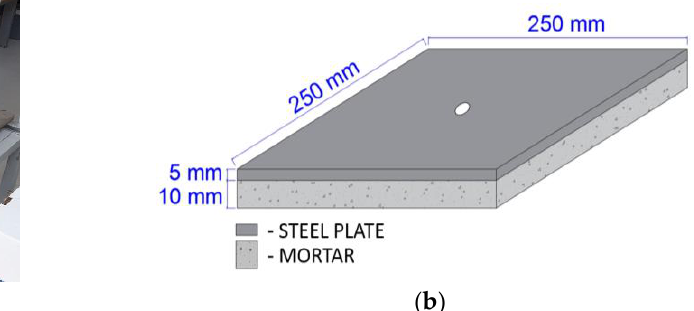
Figure 2. Manufacture of specimens: ( a ) Hobart N50 mixer; ( b ) fresh mortar in the mixer container; ( c ) steel plate with thermocouples applied; ( d ) specimen in the process of curing during the first 48 h.